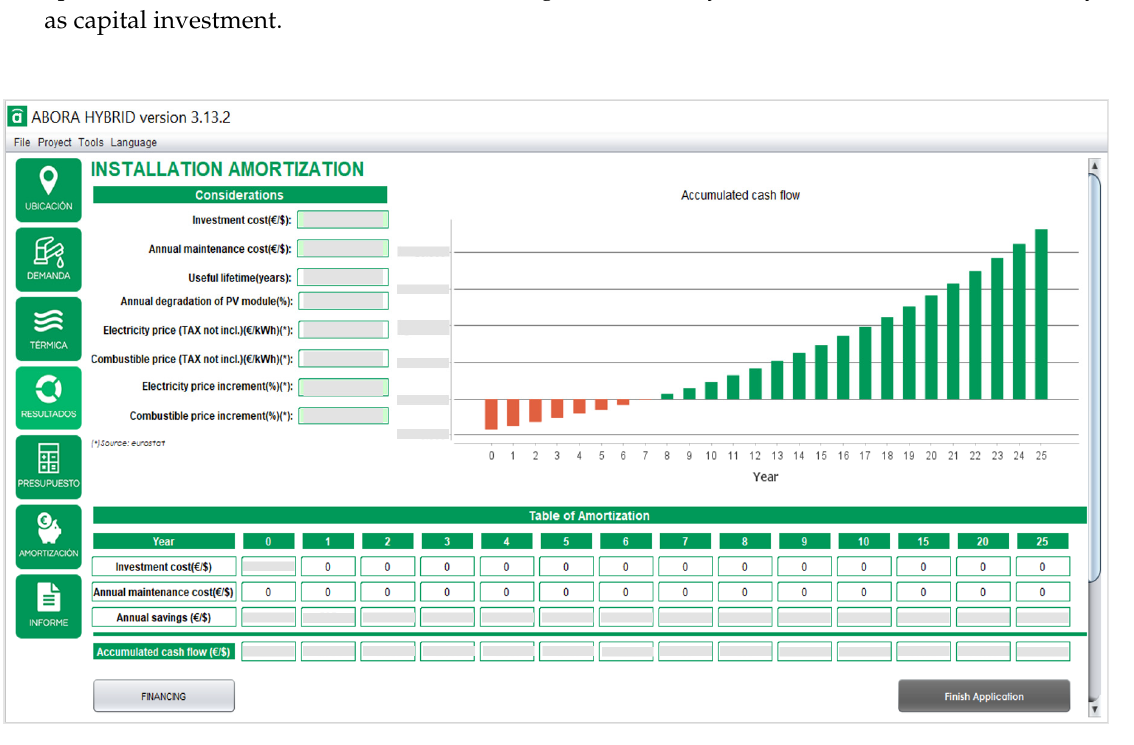
Figure 4. Cost optimization of the PVT system in the simulation tool.